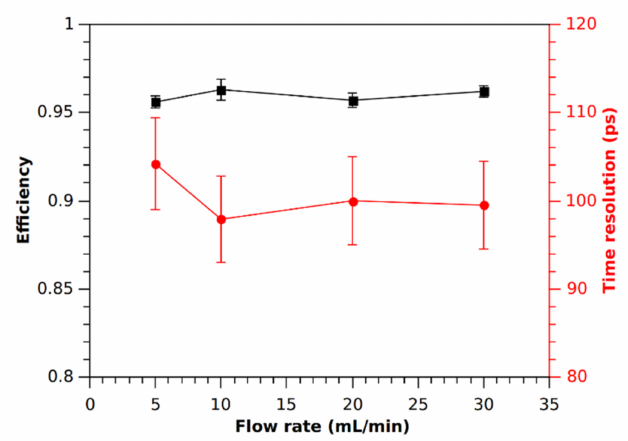
Figure 7. Performances of the high-rate sealed prototype working in different flow